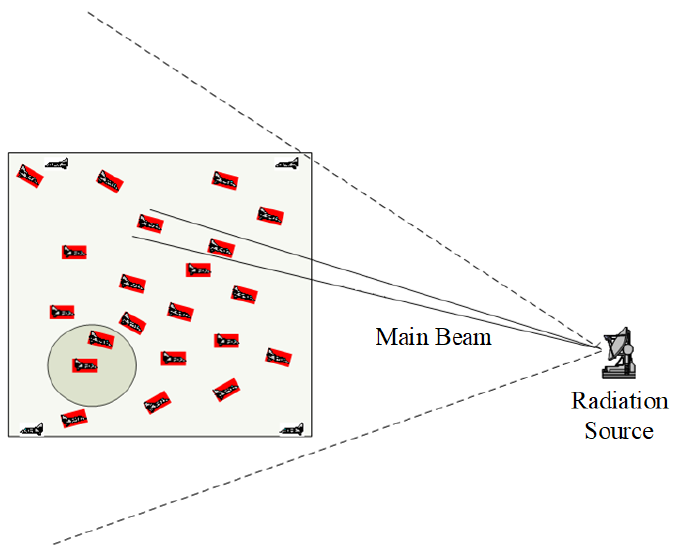
Figure 3. Distribution of UAV swarm passive localization after pheromone